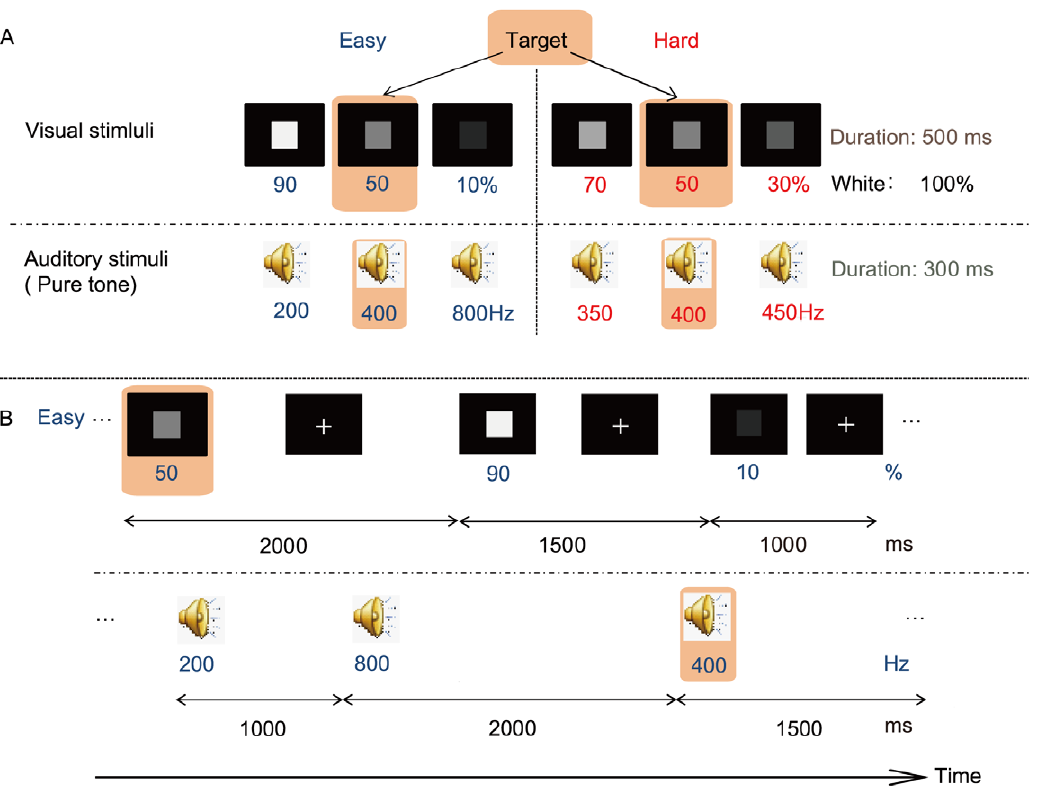
Figure 1. Divided attention task. A schematic of the range of visual and auditory stimuli (A) and an example showing the first three visual and auditory stimuli in an ‘easy’ sequence (B). V and A stimuli were independently presented in pseudo-random order. The V and A stimuli were presented at pseudo-random timings with stimulus onset asynchrony (SOA) of 1000, 1500, or 2000 ms. The + represents an inter-V stimulus interval, during which the screen showed a centered cross to maintain resting eye fixation. Twelve visual and 12 auditory stimuli constituted a 19-s block. A ‘hard’ block followed each ‘easy’ block. A run consisted of six easy blocks and six hard blocks, with 12-s inter-block pauses. Four sets of three runs separated by 54 s were conducted (the middle two runs were consecutive) during the 2-hour study. Subjects were instructed to press a button after each target stimulus (a different button for visual and auditory responses.).